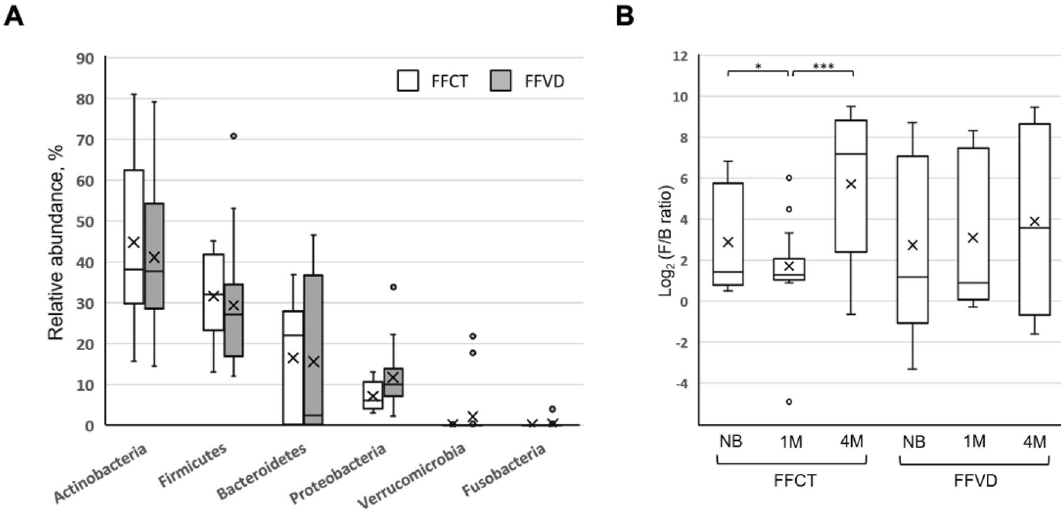
Figure 8. Comparison of relative abundances of microbial taxa between formula-fed infants with and without vitamin D supplementation. ( A ) Relative abundances of bacterial phyla within fecal microbiota of FFCT and FFVD infants at 4-month-old of age. ( B ) Box plot of log F/B ratio of the FFCT and FFVD groups. Pairwise comparisons using Mann–Whitney test. *P < 0.05. **P < 0.0005. ***P < 0.00001.